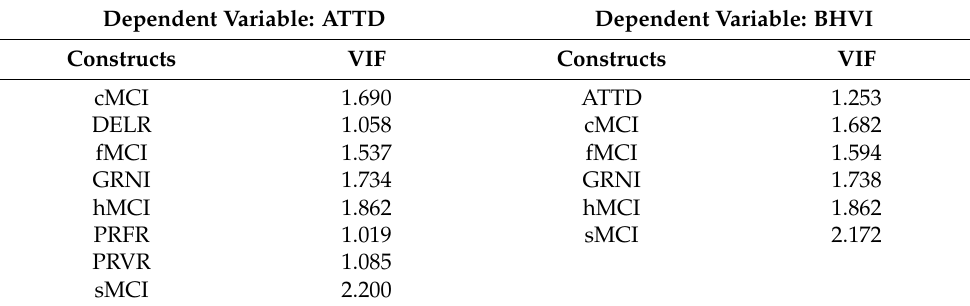
Table 3. Multicollinearity testing—VIF